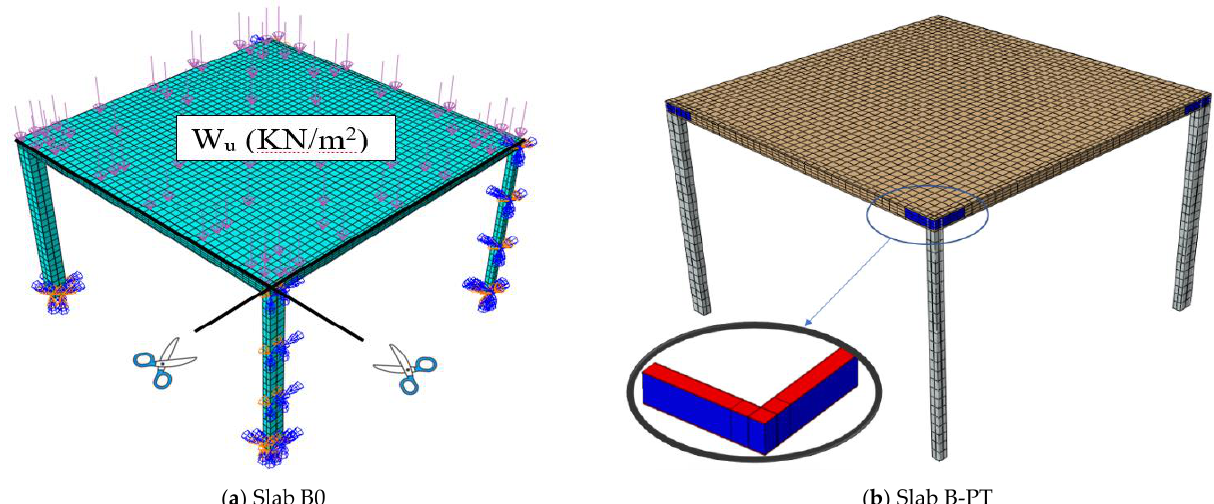
Figure 26. Numerical models of the slabs used in the case study.